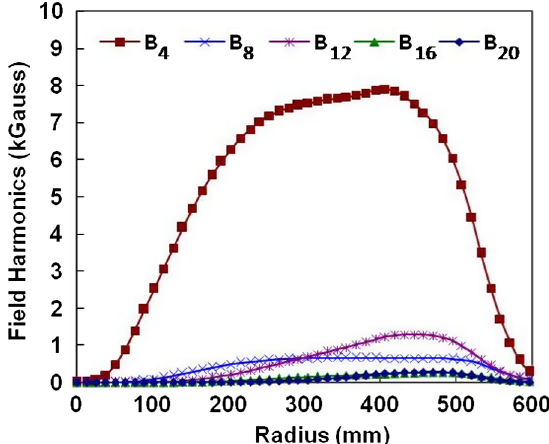
FIG. 4. Fourier harmonic components of magnetic field data. The major flutter components B of